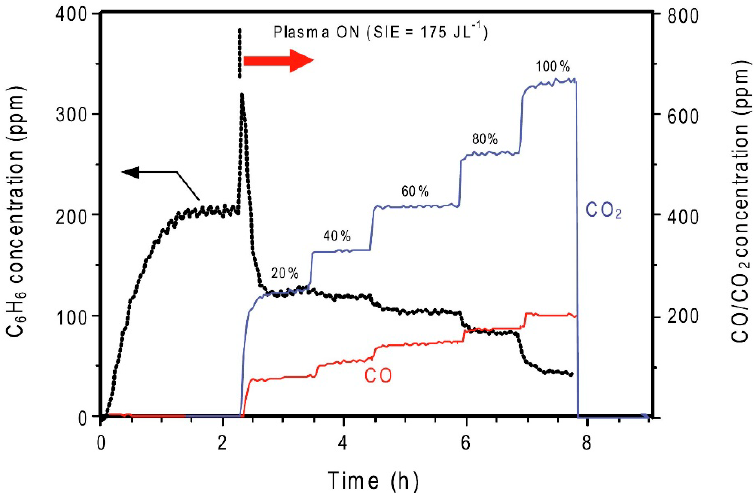
Figure 11. Effect of oxygen content on the volatile organic compounds (VOC) decomposition using a plasma-catalyst reactor (5 wt.% Cu/MOR). Applied voltage and frequency were kept constant at 16 kV and 300 Hz, respectively. Temperature was 100